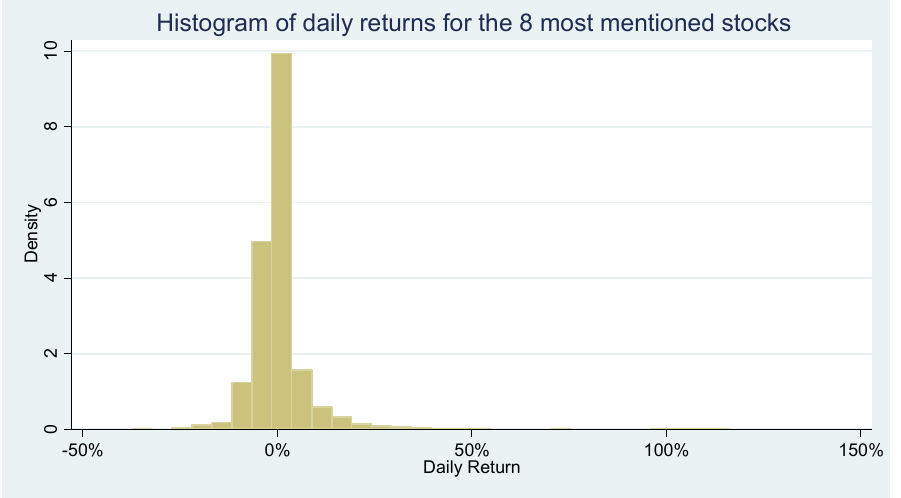
Figure 4. Histogram of the daily mentions ( left ) and daily returns ( right ) for the eight most men- tioned stocks.